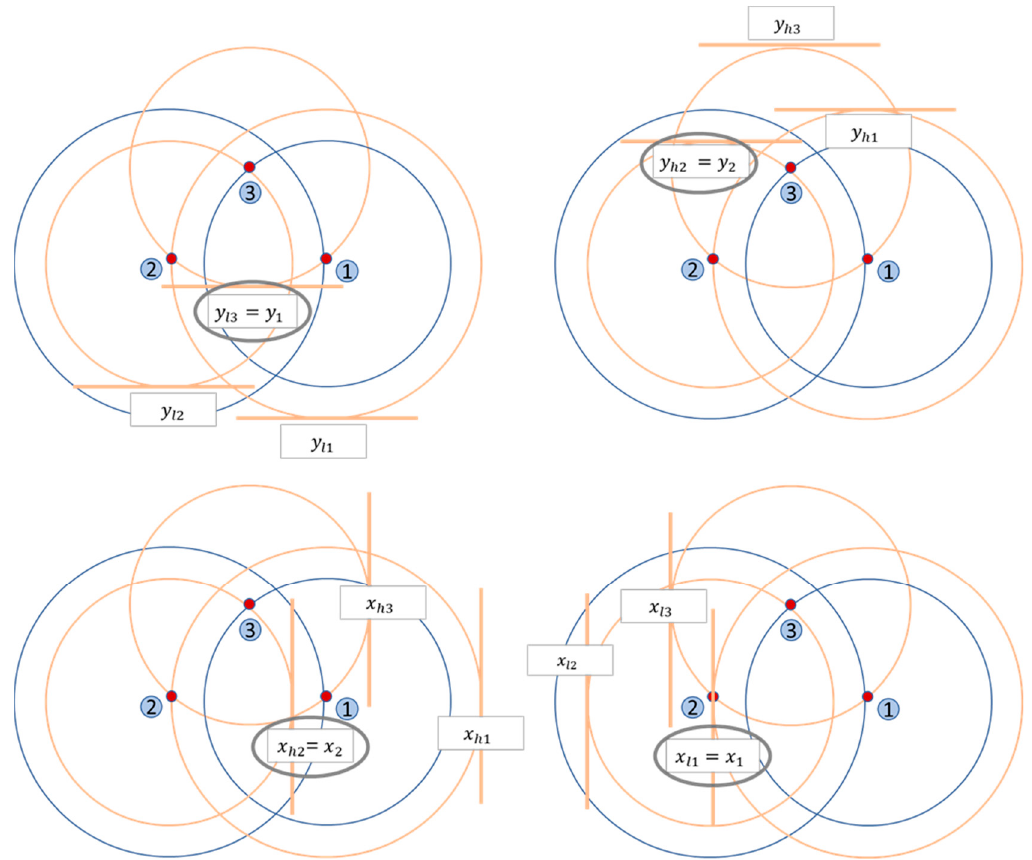
Figure 10. Restrictive limits of the area (2,1,1).